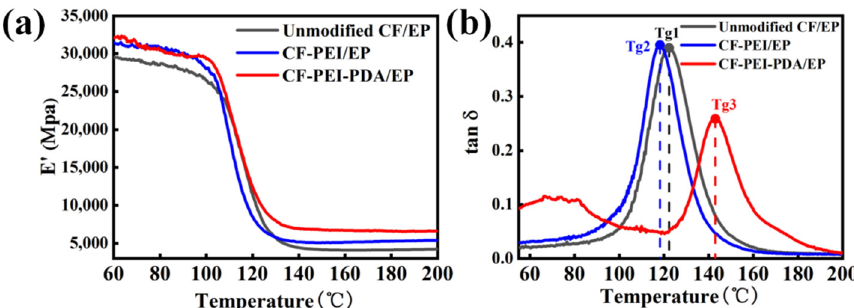
Figure 9. ( a ) Storage modulus (E ′ ) and ( b ) tan δ of different CF/EP composites.